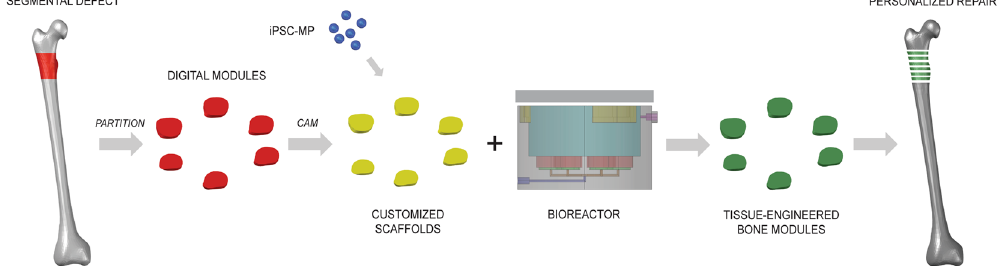
Figure 1. Segmental additive tissue engineering (SATE). Digital reconstructions of segmental bone defects (red region) are partitioned transversally to the longitudinal axis, resulting in the formation of segments (modules) with discoidal geometry and defined thickness. Following partition, the digital segments are used to assist the manufacturing of customized scaffolds and perfusion inserts for tissue culture in a novel SATE perfusion bioreactor with universal design. The tissue-engineered segments (bone modules) are finally pieced together for personalized reconstruction of segmental bone defects. Abbreviations = iPSC-MP, induced pluripotent stem cell-derived mesenchymal